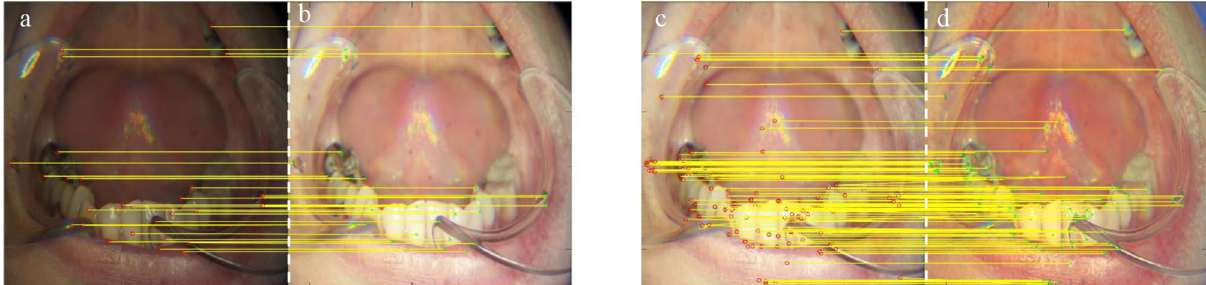
Figure 15. The features matching, ( a ), and ( b ) shows matched feature points for original and ground truth (GT) and, ( c ) and ( d ) shows matched feature points between GT and Ours.